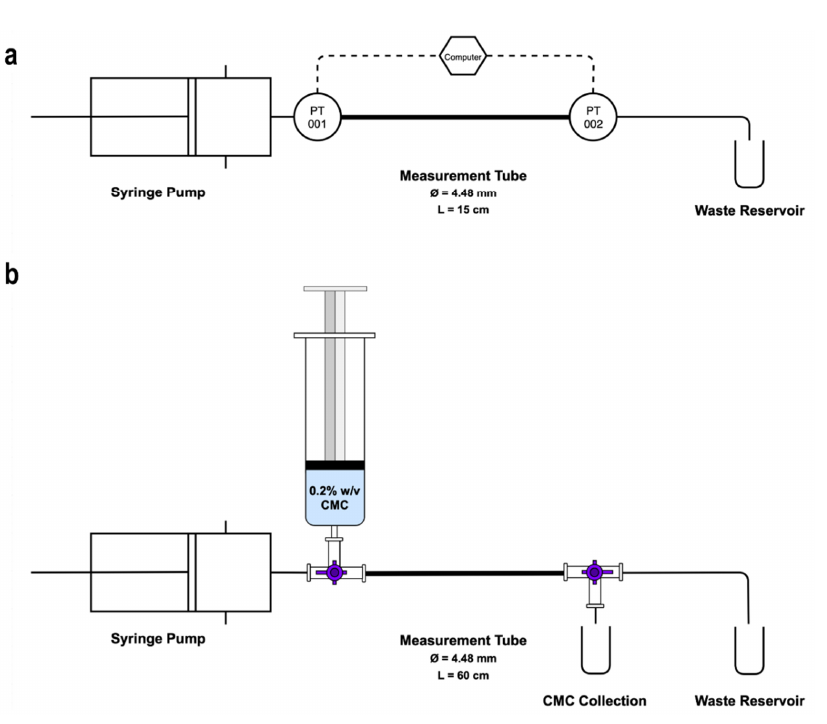
Figure 2. ( a ) Pipe viscometry apparatus. PCFs are injected into the measurement tube using a syringe pump. A computer interface is connected to the two pressure transducers (PT 001 and PT 002) that measure and record static pressure. ( b ) Blood displacement apparatus. Prior to each PCF injection, the measurement tube is purged with CMC three times and is subsequently primed with 0.2% w / v CMC solution using a 50 mL syringe. The inlet valve switches between CMC and foam injection while the outlet valve is set to CMC collection during foam injection and to waste during purge. Throughout foam injection, CMC is collected in a glass vial. Immediately at the end of injection, the second three-way valve is turned to stop CMC collection. For the capability of a defined volume of foam to displace blood (or a blood substi- tute) to be evaluated, a rheological replica of blood must be produced. Previously, re- searchers have used 30% v / v glycerol solutions to mimic blood; however, blood is a non- Newtonian shear-thinning fluid [40,41] while glycerol solutions are Newtonian fluids [42,43]. A better substitute therefore may be carboxymethyl cellulose (CMC) that has been demonstrated to exhibit a shear-thinning behaviour [44,45]. Benchabane et al. have char- acterised the rheology of a variety of CMC solutions using the Cross model (see Equation (6)). This model can thus be used to calculate apparent viscosity of the blood surrogate; where 𝜇 (cid:2868) and 𝜇 (cid:2998) represent viscosity values at zero and infinite shear rates ( 𝛾(cid:4662) ), while 𝜆 (cid:3030) and 𝑚 represent a time constant and a dimensionless rate constant, respectively [44].